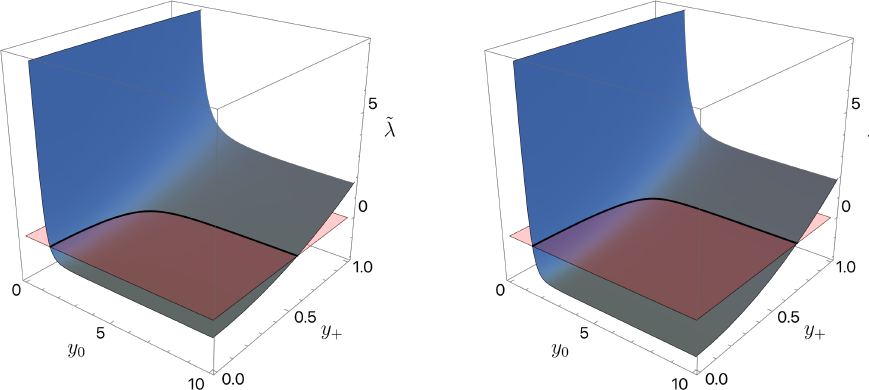
as a function of y 0 and y + for d = 4 +